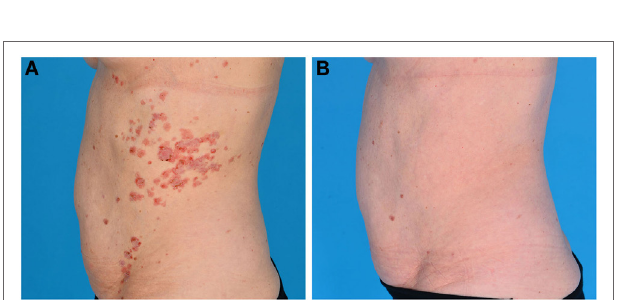
FigUre 2 | Epidermolysis bullosa acquisita (EBA) in a 59-year-old female. (a) Nummular erythematous plaques, papules and circinate configurated crustae, vesicles, and bullae on the trunk, before rituximab (RTX) treatment. (b) Remission off therapy after RTX treatment.